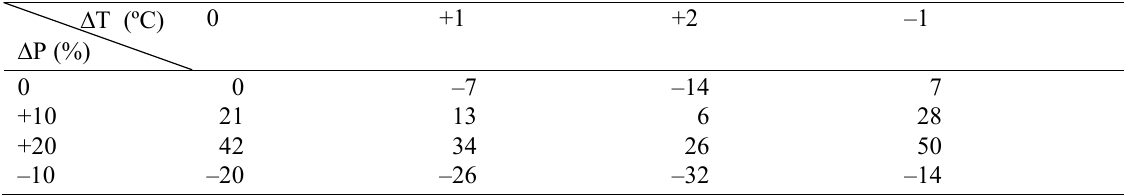
Table 1 Sensitivity (%) of the simulated annual runoff of the Northern Dvina River to changes in mean annual air temperature and precipitation over the river basin. ∆ T